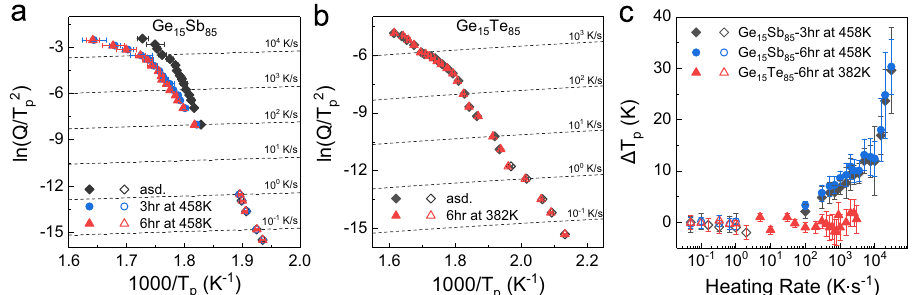
Fig. 3 | Kissinger plots for the crystallization processes of Ge 15 Sb 85 and Ge 15 Te 85 . The crystallization peak temperatures T p atlow and high heating rates Q are measured by DSC (open symbols) and ultrafast Flash DSC (solid symbols), respectively. a Crystallization of as-deposited Ge 15 Sb 85 , and the samples annealed for 3 and 6h at 458K. The error bars are the standard deviations of averaging ten times of measurements (see “ Methods ” and Supplementary Table 1).